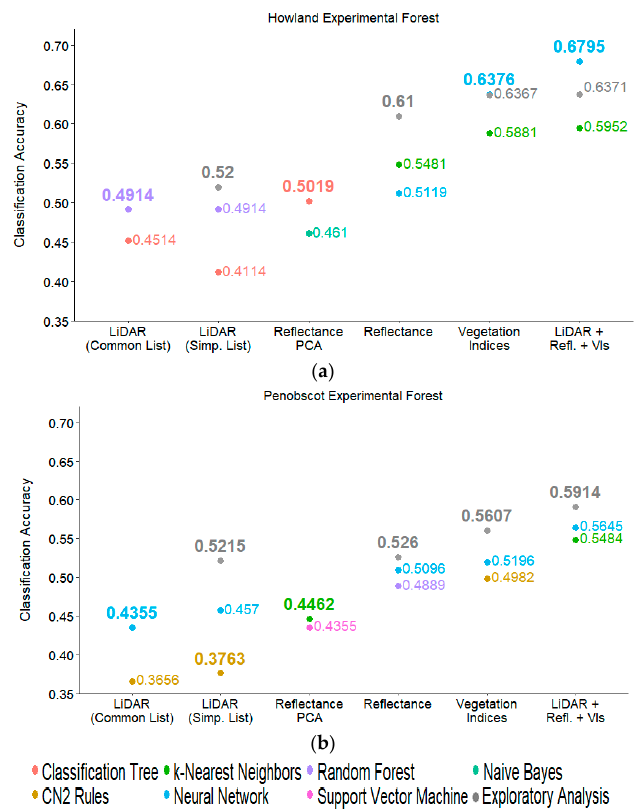
Figure 4. Classification accuracies achieved by machine learners run on simplified datasets from Howland Experimental Forest ( a ) and Penobscot Experimental Forest ( b ). Dot color represents the machine learning technique used in each case. Gray dots represent classification accuracies achieved during the exploratory analysis step using the full dataset, and are shown as a comparison.